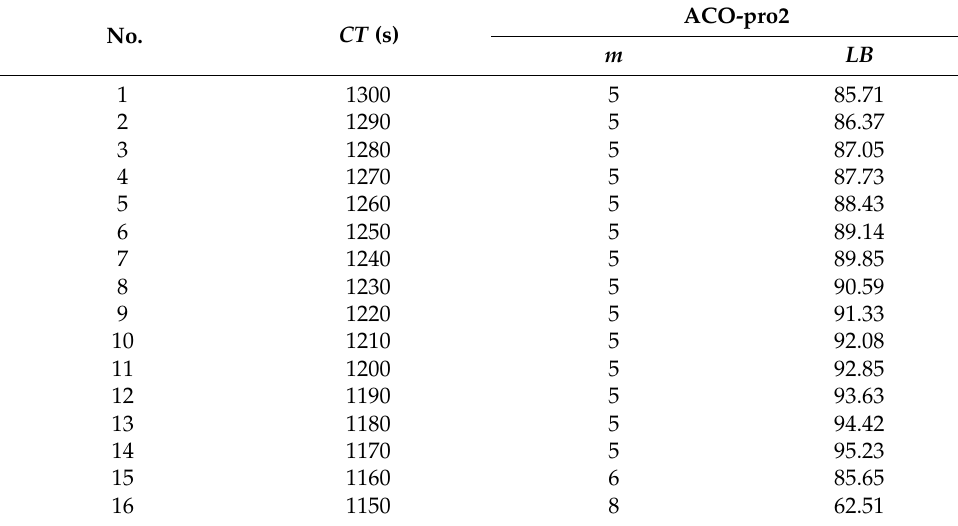
Table 2. Comparison of test results of each cycle time. No. CT